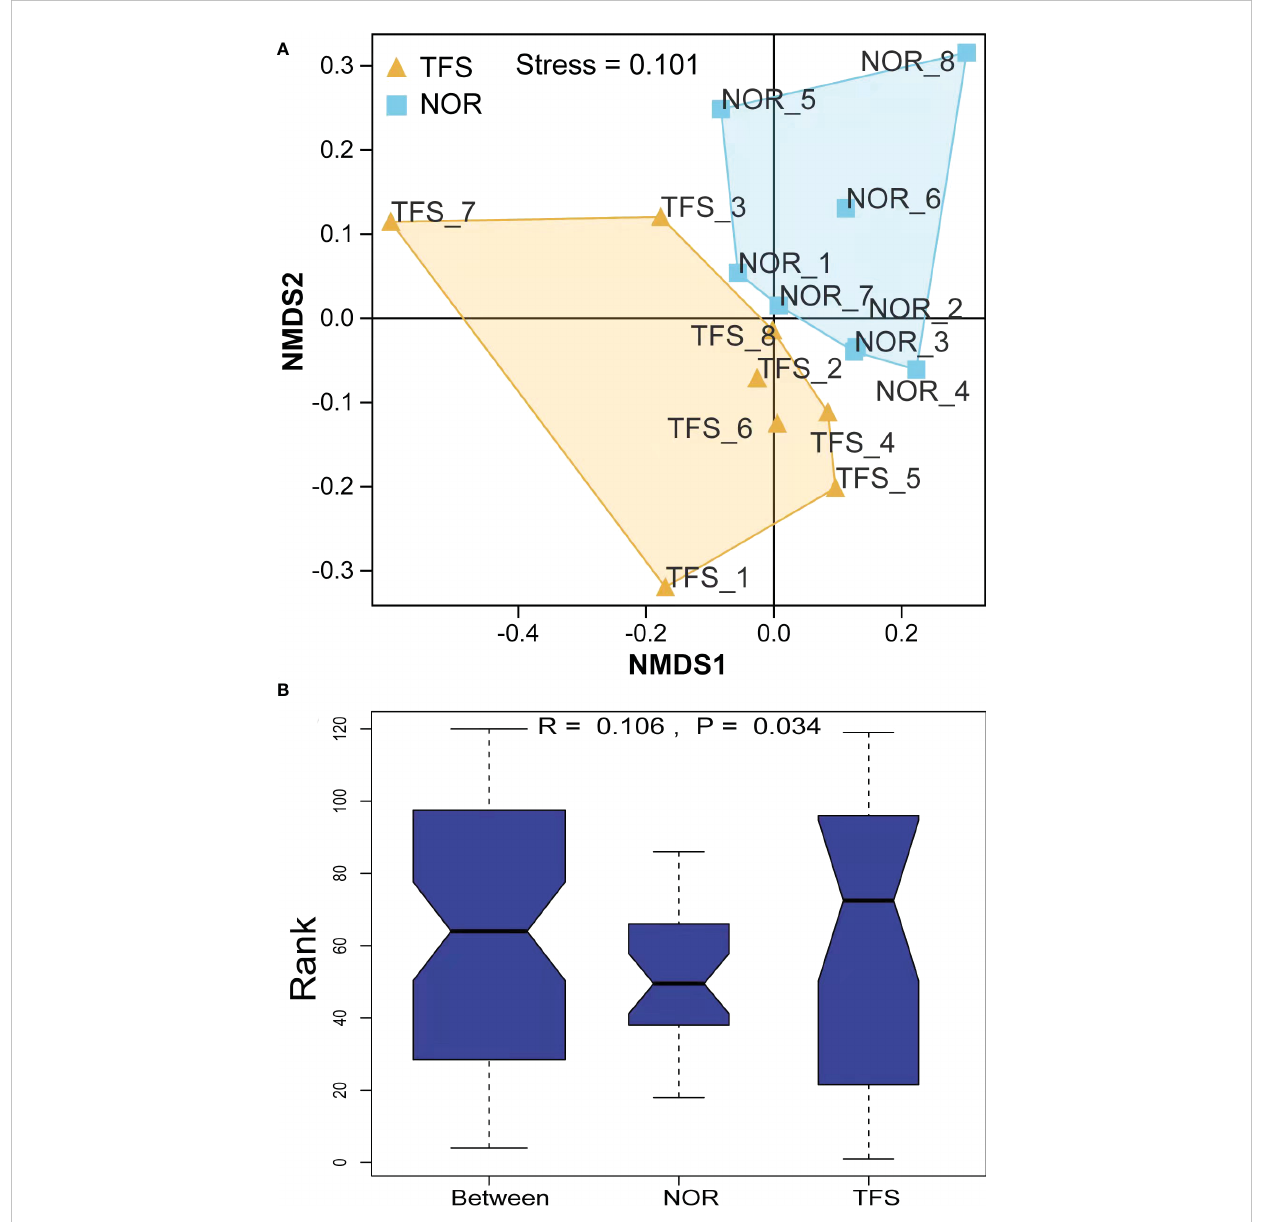
FIGURE 6 Beta diversity difference in the intestinal microbiota of normal (NOR) and TFS D. hystrix . (A) Nonmetric multidimensional scaling (NMDS) analysis base on Bray-Curtis dissimilarity index. (B) Statistical signi fi cance via Analysis of Similarity (ANOSIM) test with 999 permutations.